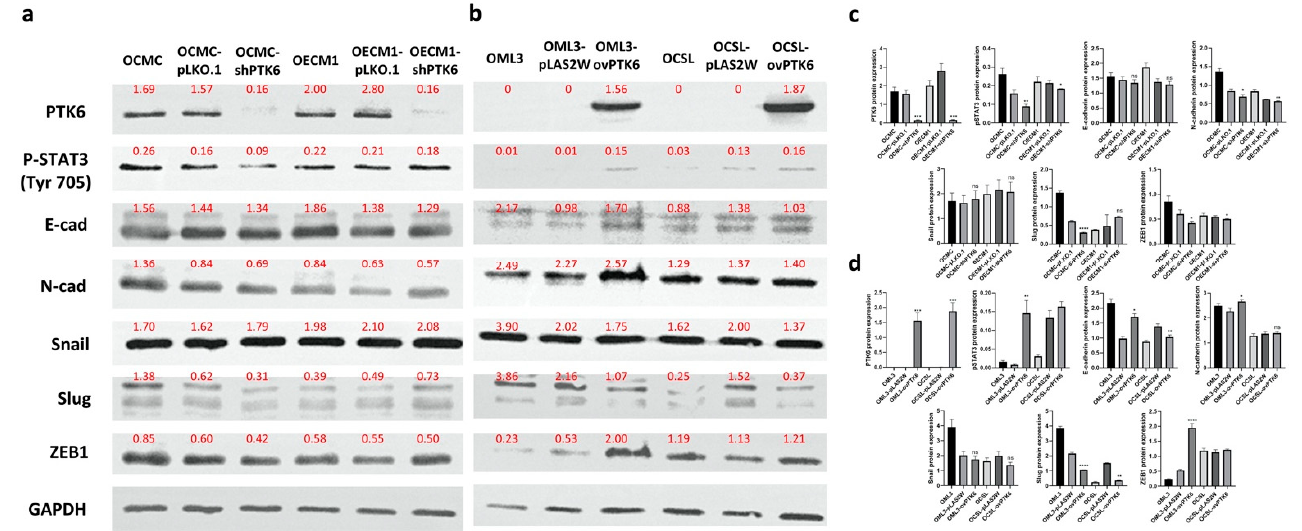
Figure 6. Analysis of candidate genes downstream of PTK6. ( a , b ) The protein levels of candidate genes downstream of PTK6 downstream were detected through Western blotting. ( c , d )The intensities of Western blotting data were measured with ImageJ and normalized to GAPDH. * p < 0.05; ** p < 0.01; *** p < 0.005; **** p < 0.001; ns: not significant.